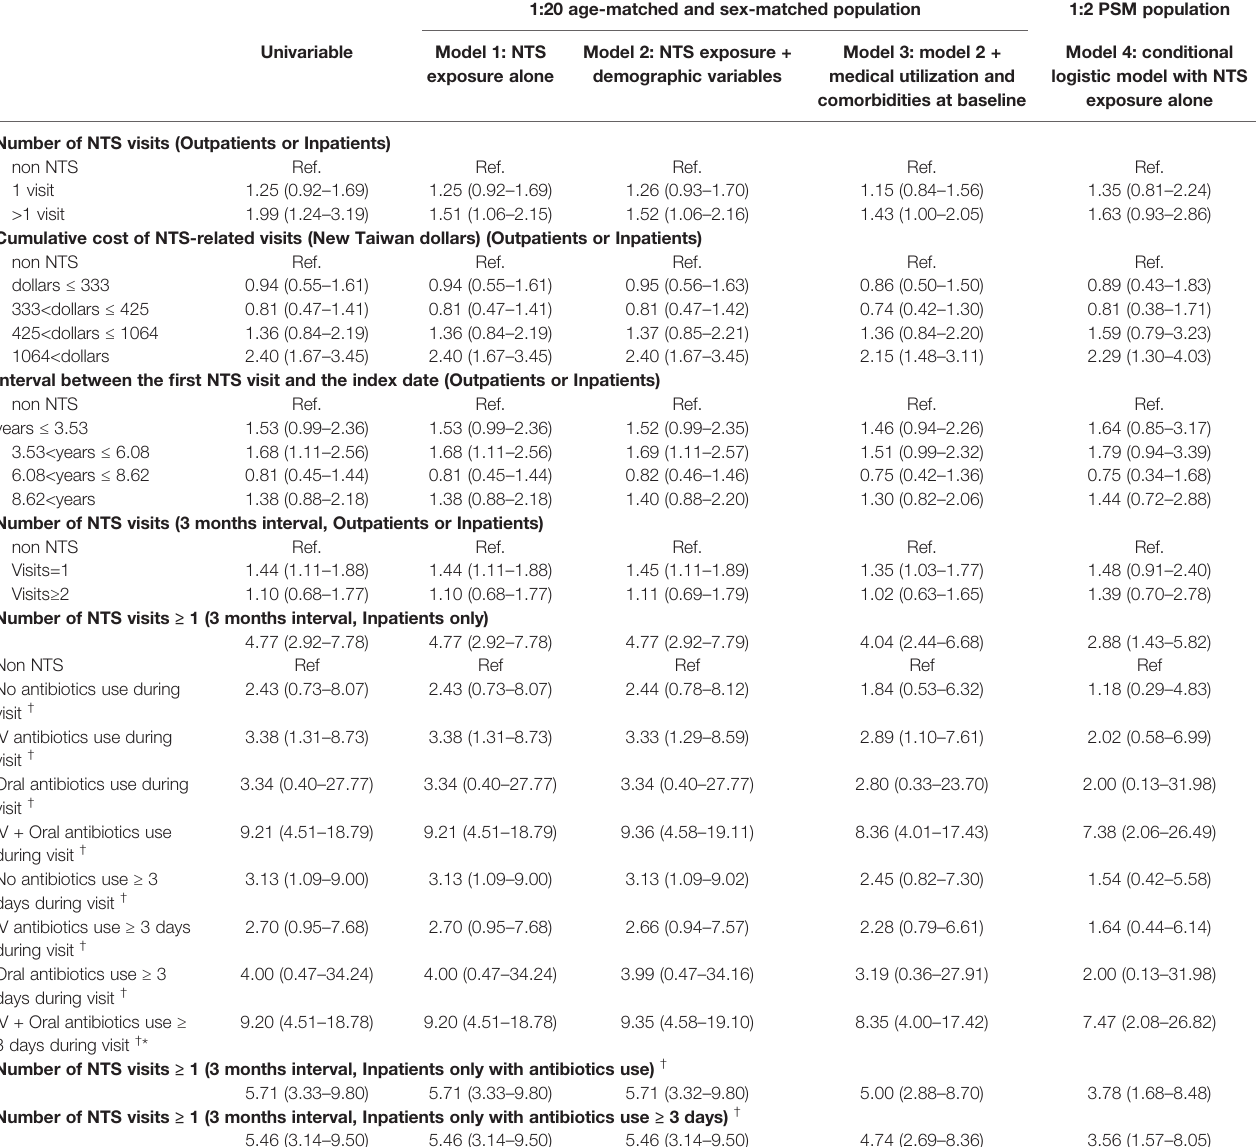
1:20 age-matched and sex-matched